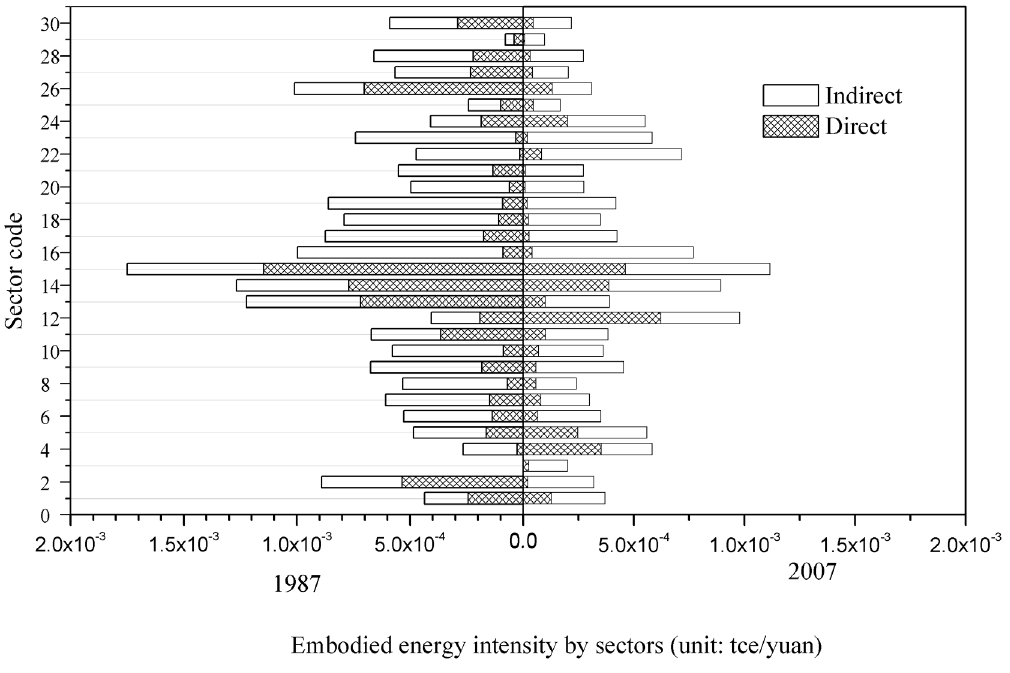
Figure 4. Embodied energy intensity by sector between 1987 and 2007 in Beijing (see Table 2 for sector code definitions).